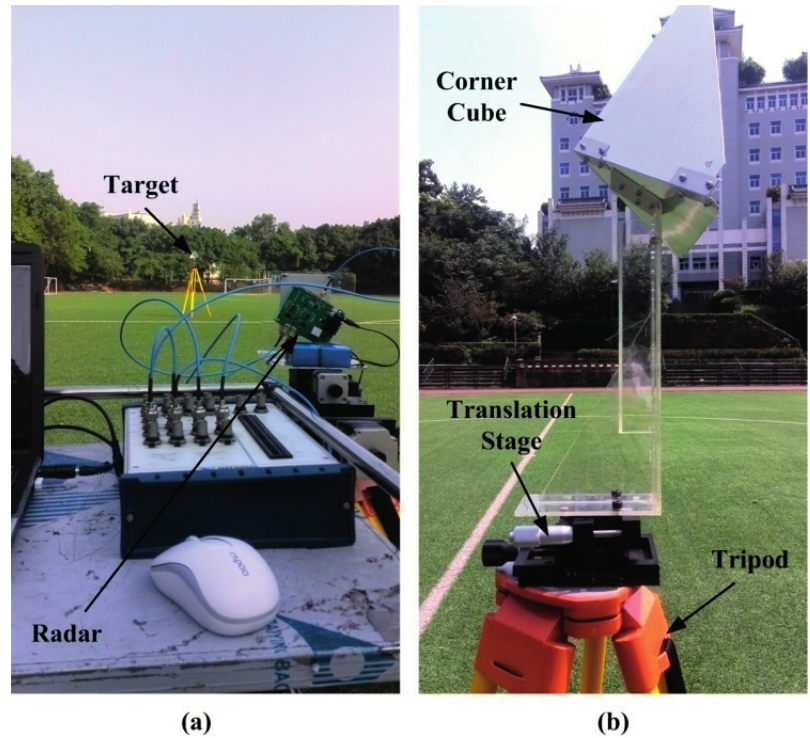
Figure 11. Photograph of the outdoor experiment for: ( a ) single target setup; ( b ) the target with a wooden